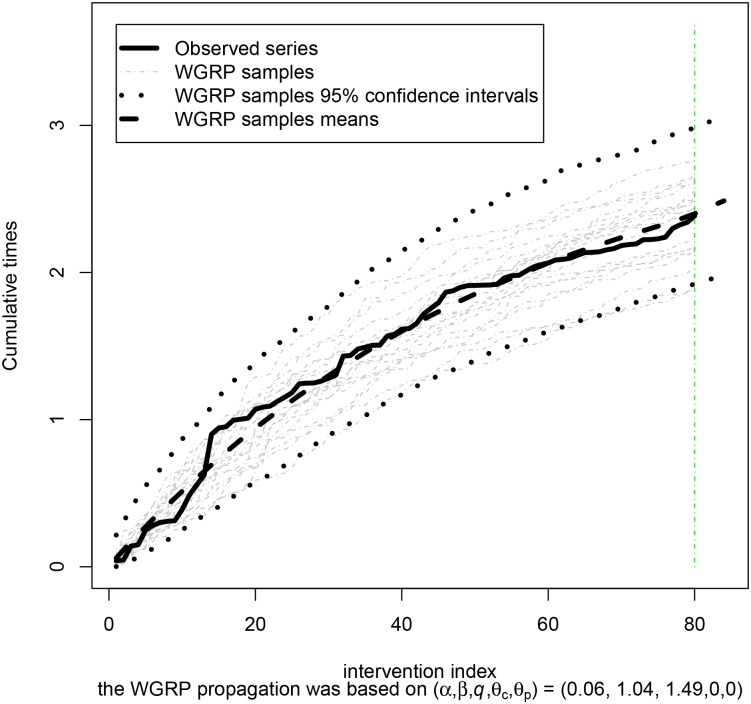
WGRP adjustment for Windshield.WGRP adjustment to the [20] Windshield data.